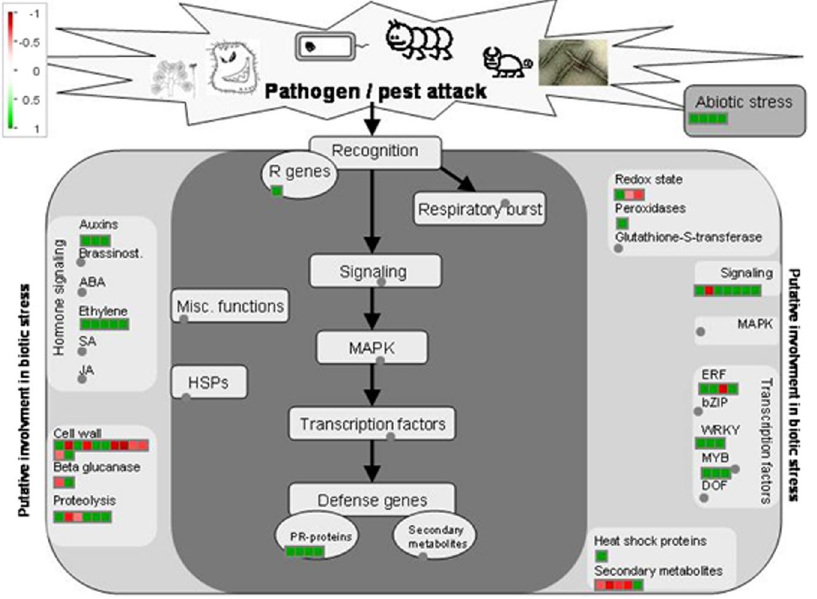
Figure 7. MAPMAN visualization of Arabidopsis Affymetrix data describing the differentially expressed genes involved in plant defense responses in NOG1-1 RNAi and nog1-2 lines. The Affymetrix microarray analysis showed a number of up- and down-regulated genes in NOG1-1 RNAi and nog1-2 lines compared to wild-type (Col-0) without treatment. MAPMAN was used to analyze the gene function and biological pathways of NOG1- 1 and NOG1-2 . Four-week old seedlings grown on half MS media were collected for RNA extraction. Three biological replicates were used for each NOG1-1 RNAi and nog1-2 without any treatments. Color patterns from red (upregulation) to green (downregulation) indicate the change of gene